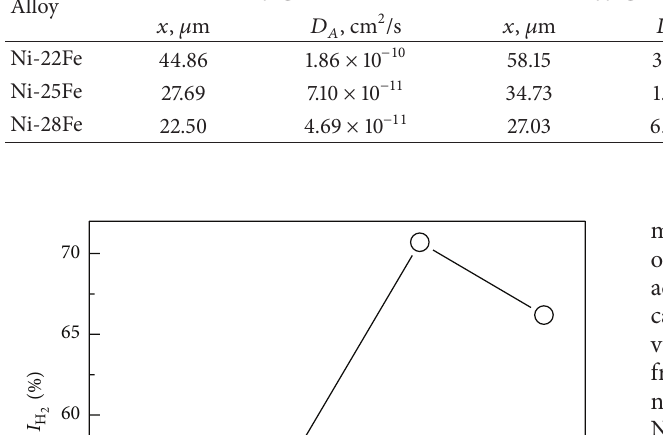
Table 2: The value of 𝑥 and 𝐷 𝐴 of the ordered Ni Alloy